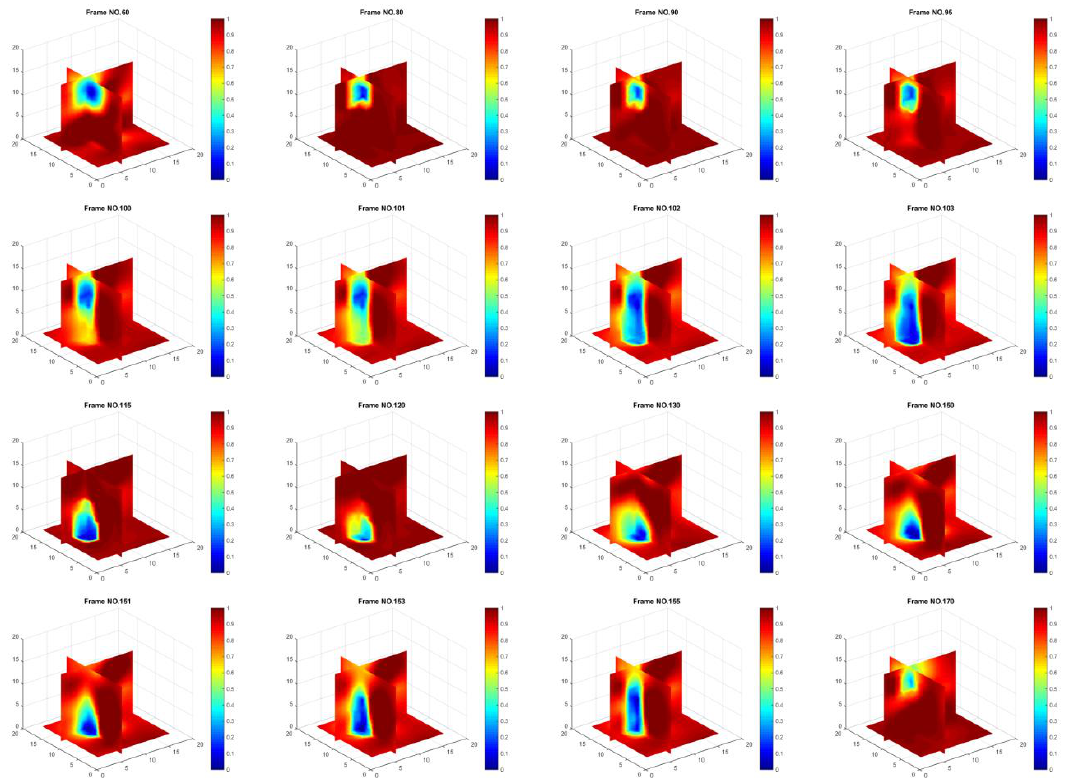
Figure 14. Reconstructions of the movement using temporal TV: a dynamic 3D image was produced, and 16 images selected among 200 frames showing that the movement of inclusion was started from the top move down to the bottom, and come back to top. The Blue object in images (refer to the color bar) corresponds to where the inclusion arrived at that time-step.